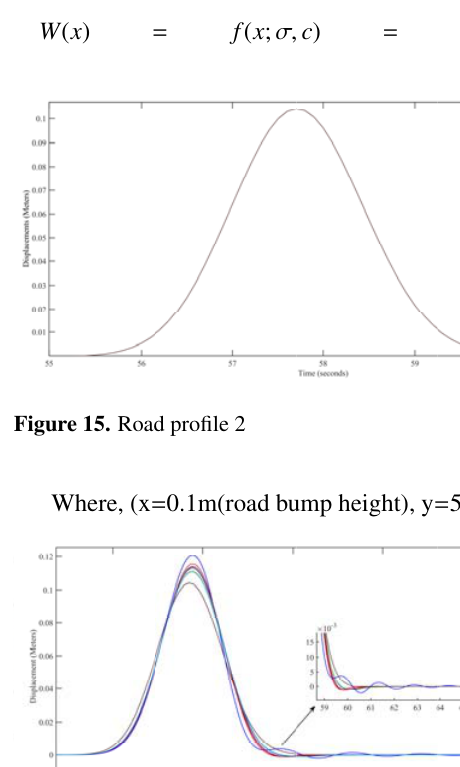
Figure 11. Road profile 1a